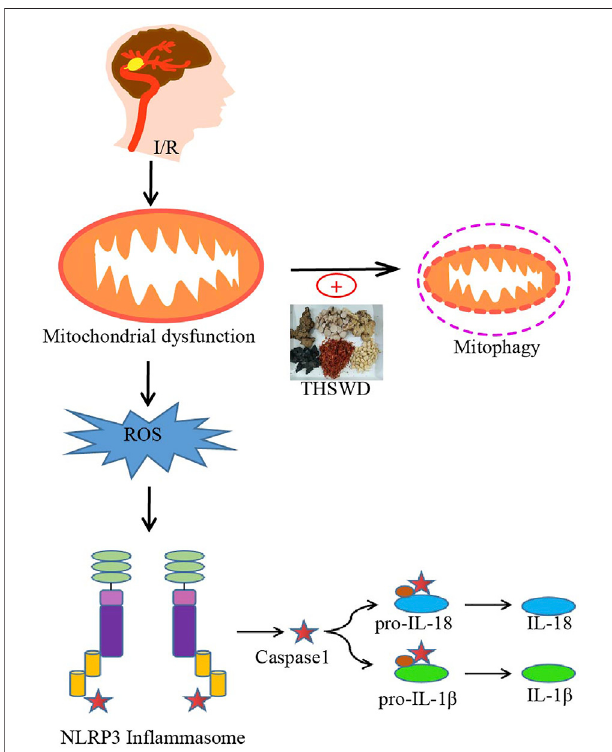
FIGURE 7 | Potential processes of THSWD effects on mitochondrial autophagyandNLRP3in fl ammasomeafterCIRI.Brie fl y,CIRI-inducedrelease ofROSfromdamagedmitochondriathenactivatestheNLRP3in fl ammasome and secondaryin fl ammatoryresponses.THSWD treatmentupregulated mitochondrial autophagy and reduced reactive oxygen species production, thereby inhibiting NLRP3-mediated in fl ammatory responses.